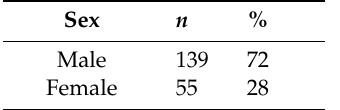
Table 2. Summary of gender distribution for the cohort of 194 mRCC